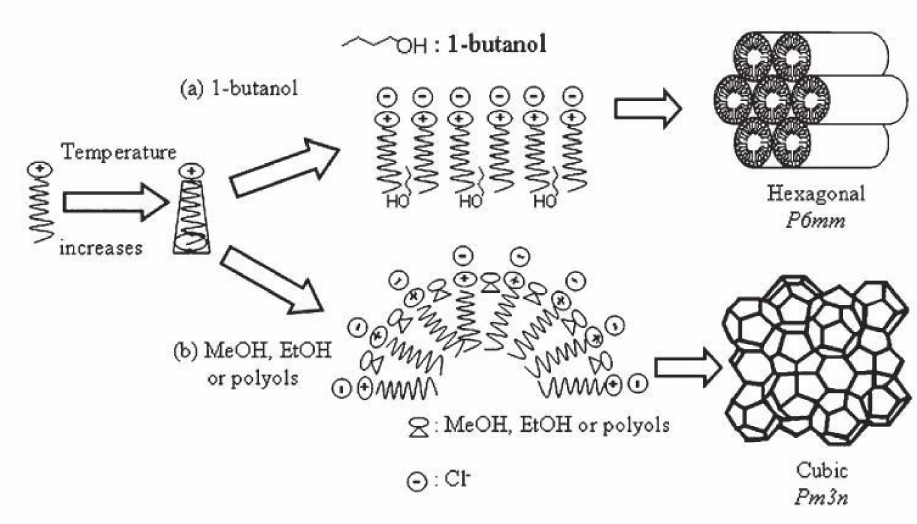
Figure 4. The proposed schema of changes in organization of a surfactant with increasing temperature in the presence of ( a ) 1-butanol and ( b ) ethanol, methanol or polyols. Reprinted from Reference [27] with permission from The Royal Society of